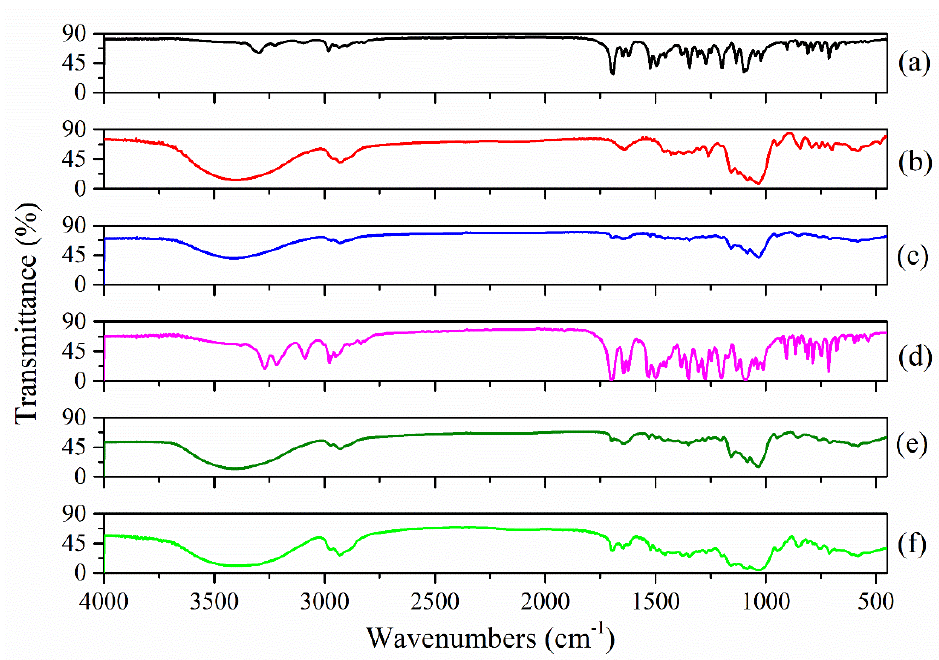
Figure 3. FTIR spectra of ( a ) Nim; ( b ) HP- β -CD; ( c ) Nim–HP- β -CD physical mixture; ( d ) Nim– HP- β -CD coprecipitation method; ( e ) Nim–HP- β -CD lyophilization method; ( f ) Nim–HP- β -CD knead- ing method.